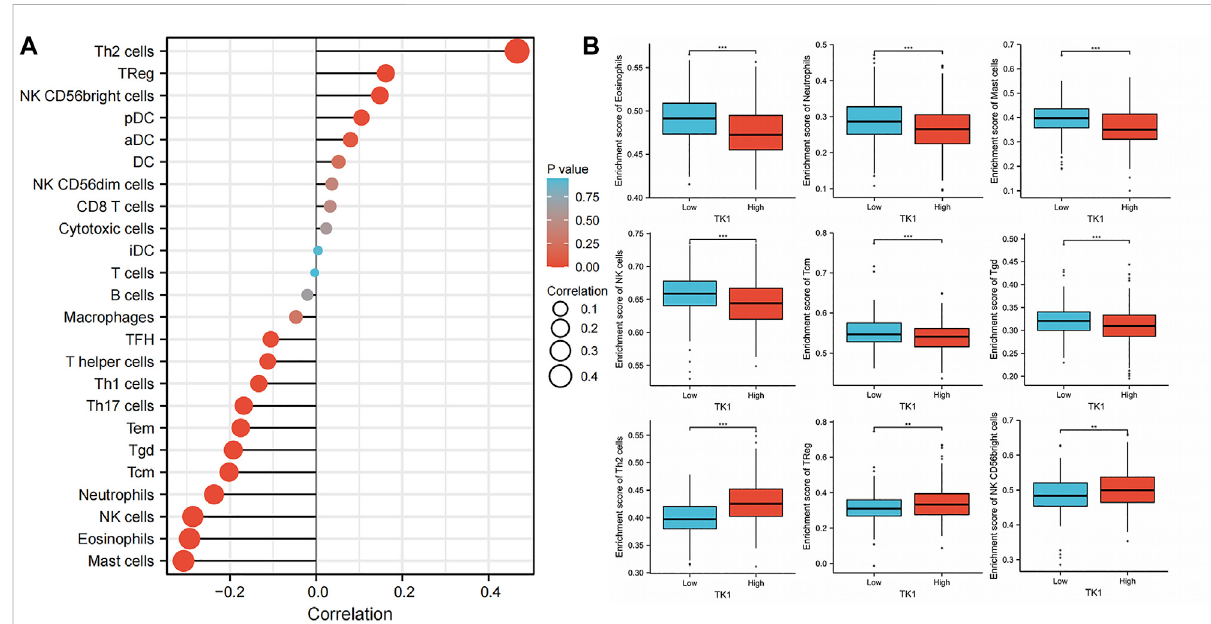
FIGURE 7 Effect of immune cell invasion on TK1 expression in individuals with PCa. (A) Relationship between the invasion contents of 24 immune cell types and the expression pro fi le of TK1. (B) Comparison of the most associated levels of immune cell invasion in the high and low TK1 expression groups, including eosinophils, Tcm, neutrophils, mast cells, Tgd, NK cells, Th2 cells, TRed cells, and NK CD56bright cells. (* < 0.05, ** < 0.01, *** <